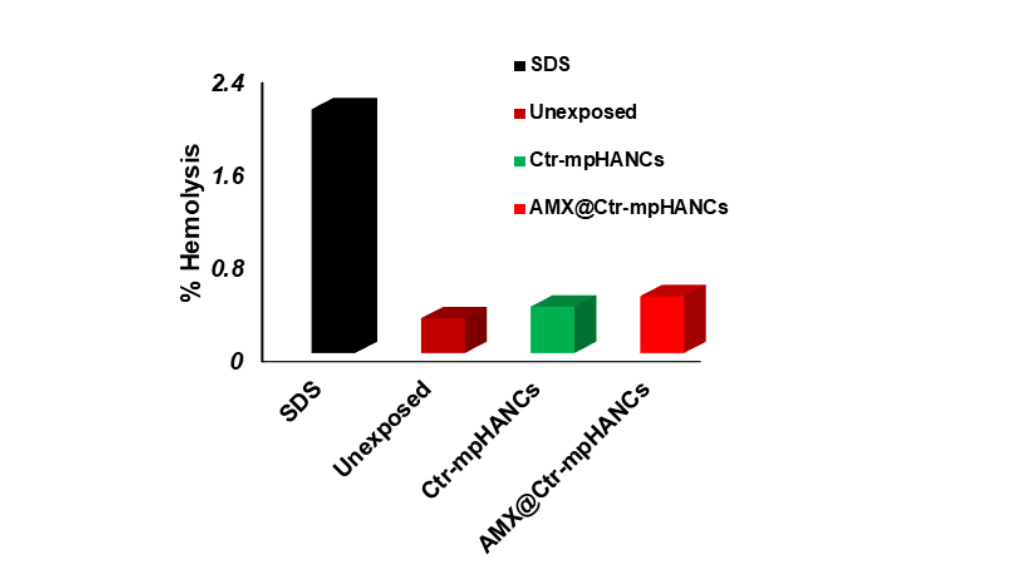
10 of 14 Figure 5 . Drug release profile of AMX@Ctr–mpHANCs at pH 2.0, 4.5, and 7.4. 3.7. In vitro Hemolysis After in vivo administration, plasma proteins and RBCs are the physiological constit- uents with which drug/NCs interact. Because of this, it is critical to check the interaction